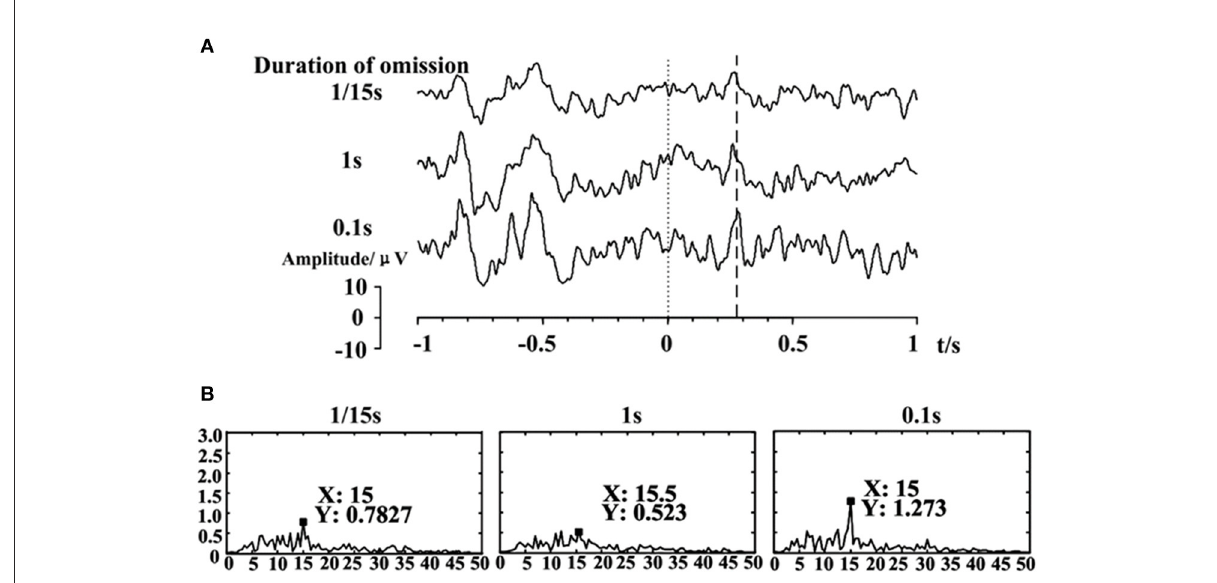
FIGURE5 (A) EEG responses to different omitting durations. (B) The frequency analysis of the different duration of omitting at Oz electrode, with a stimulation frequency of